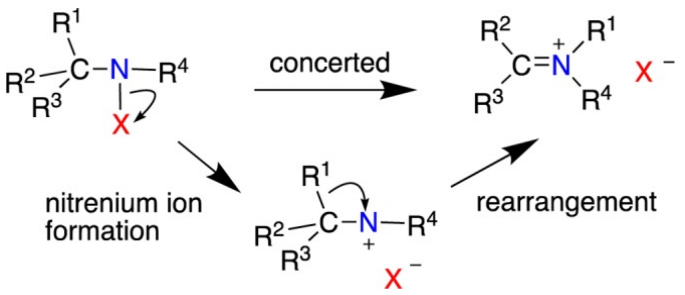
Figure 6. Nonaryl nitrenium ions and their rearrangements (computational studies after Falvey, 2018)